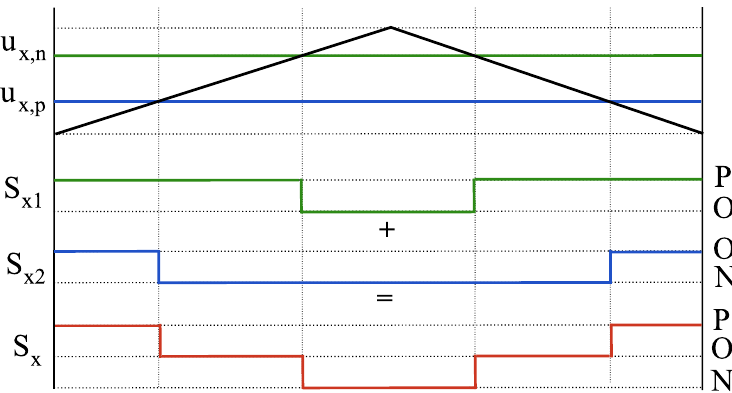
Figure 4. Construction of the phase leg state using positive and negative modulation waves. (Green: negative modulation wave switching; Blue: positive modulation wave